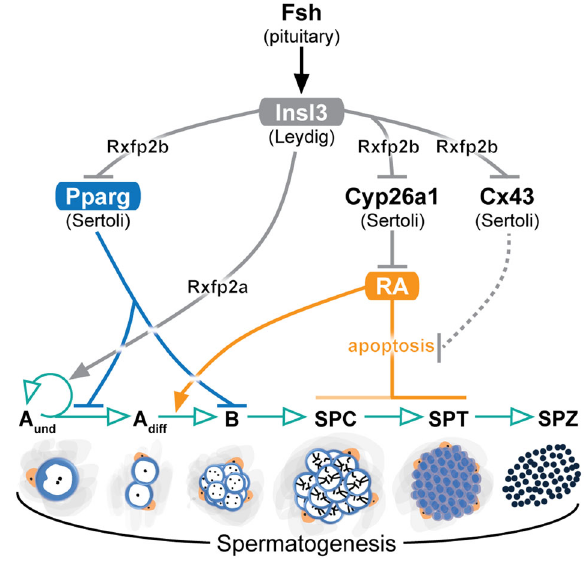
Fig. 7 Schematic illustration showing the endocrine and paracrine regulation of zebra fi sh Insl3 and the stages of spermatogonial development affected. Described effects are indicated by black (Fsh), gray (Insl3), blue (Pparg), and orange (RA) arrows, while germ cell development or germ cell-mediated effects are indicated in green. Gray dashed line denotes no experimental evidence reported. Fsh, follicle-stimulating hormone; Insl3, insulin-like 3; Pparg, peroxisome proliferator-activated receptor gamma; RA, retinoic acid; Cx43, connexin 43; Rxfp2a, relaxin family peptide receptor 2a; Rxfp2b, relaxin family peptide receptor 2b; A und , type A undifferentiated spermatogonia; A diff , type A differentiating spermatogonia; B, type B spermatogonia; SPC, spermatocytes;